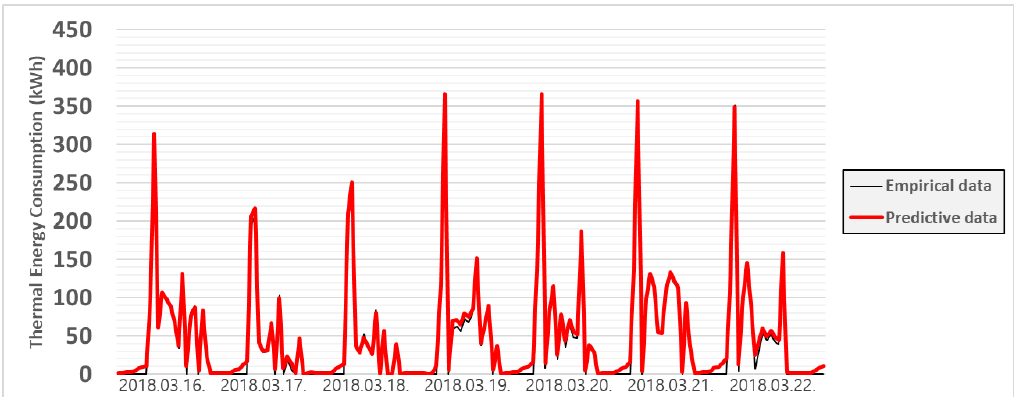
Figure 12. Case 3: Comparison between empirical and predictive data.